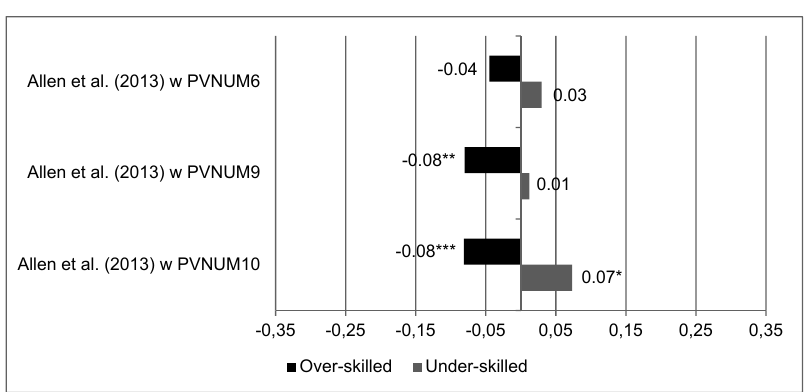
Figure 2 Mincer-regression coefficients of skill-mismatch measure of Allen et al. (2013) with three different plausible values for